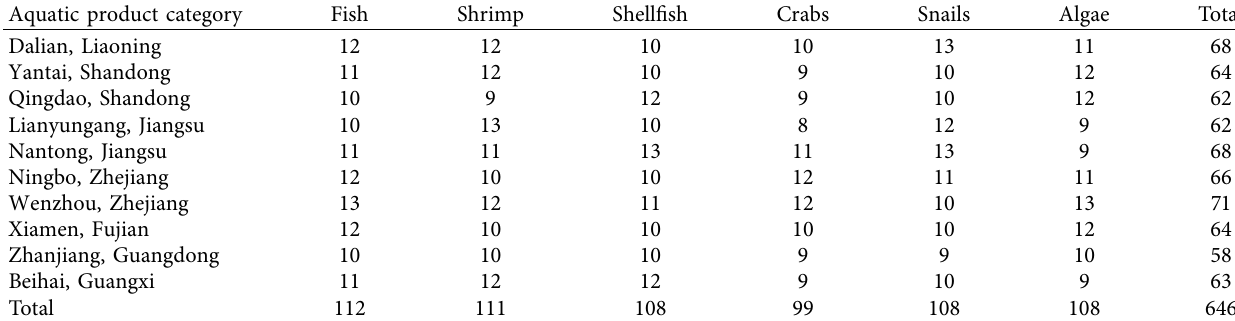
Table 1: Sample collection location.